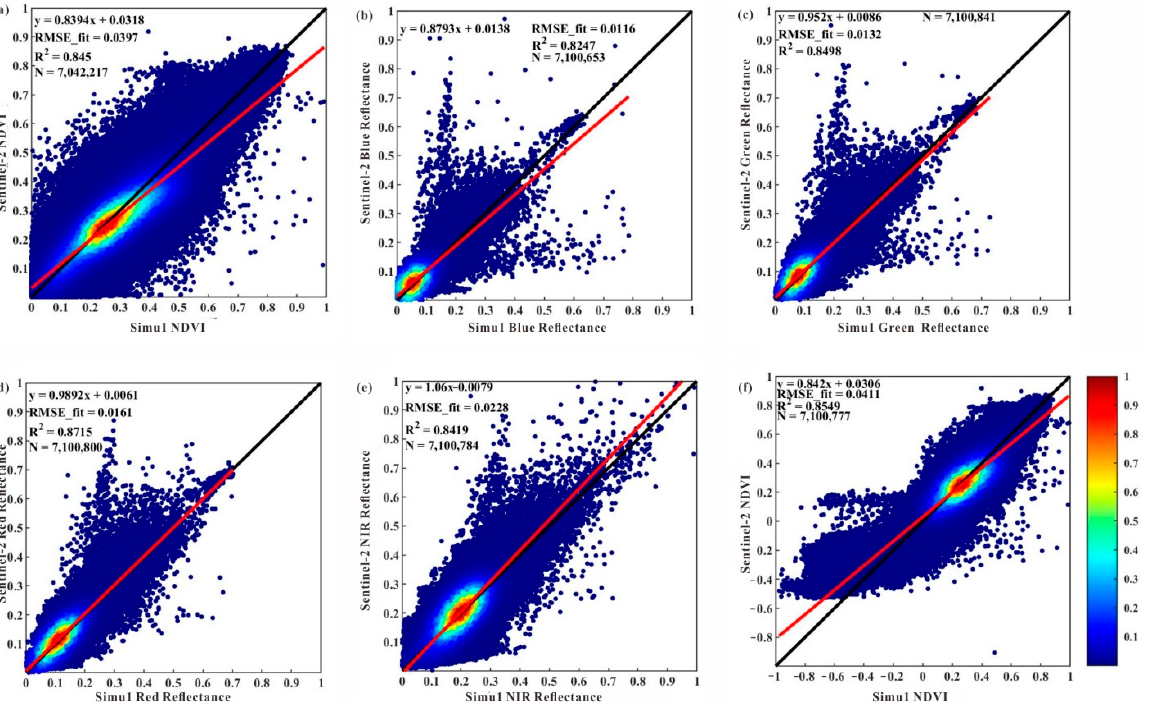
Figure 10. Scatter plot of the actually acquired and reconstructed image in Case 1 situation in Area A (24 October 2020). ( a ) NDVI in the range of [0–1]; ( b – e ) surface reflectance in blue, green, red and NIR band, respectively; ( f ) NDVI in the range of [ − 1–1]).